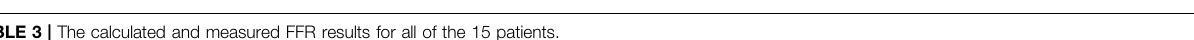
TABLE 3 | The calculated and measured FFR results for all of the 15 patients. Patient